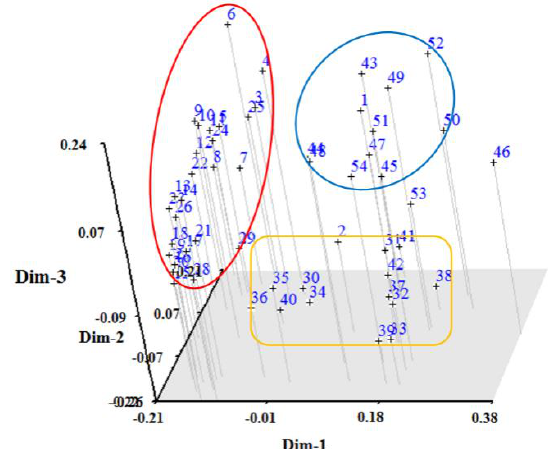
Figure 8. Three-dimensional plot of the PCoA analysis based on RAPD markers of 54 R. communis L. seed samples.